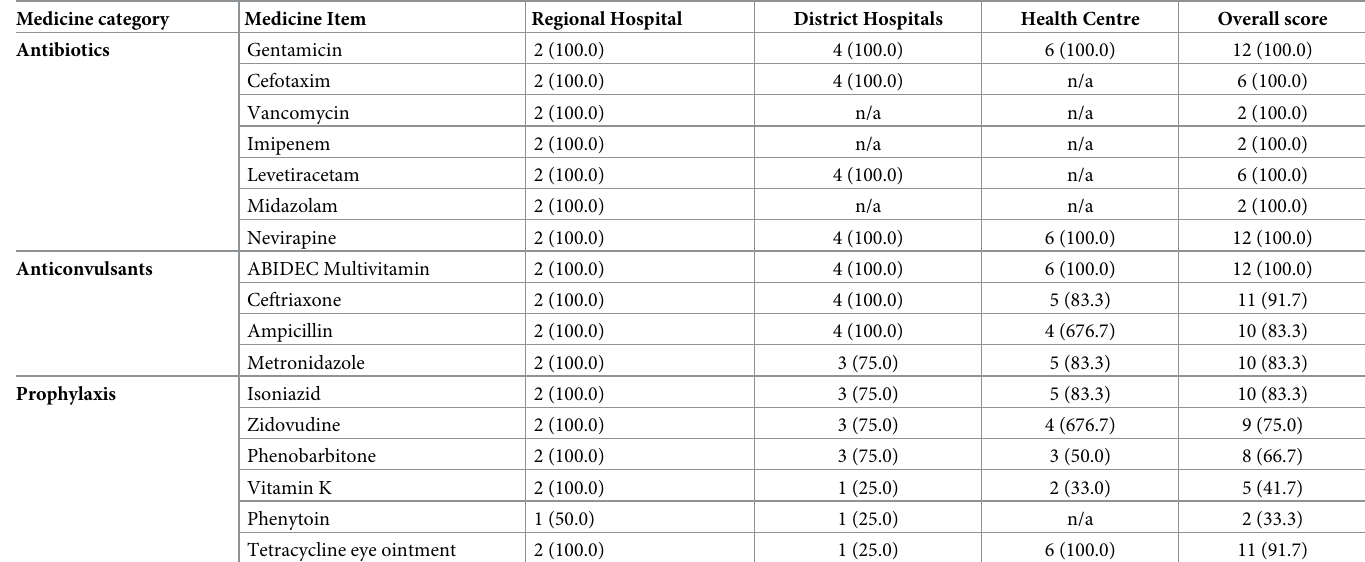
Table 4. Availability of essential medicines by the level of newborn care, (N = 12).